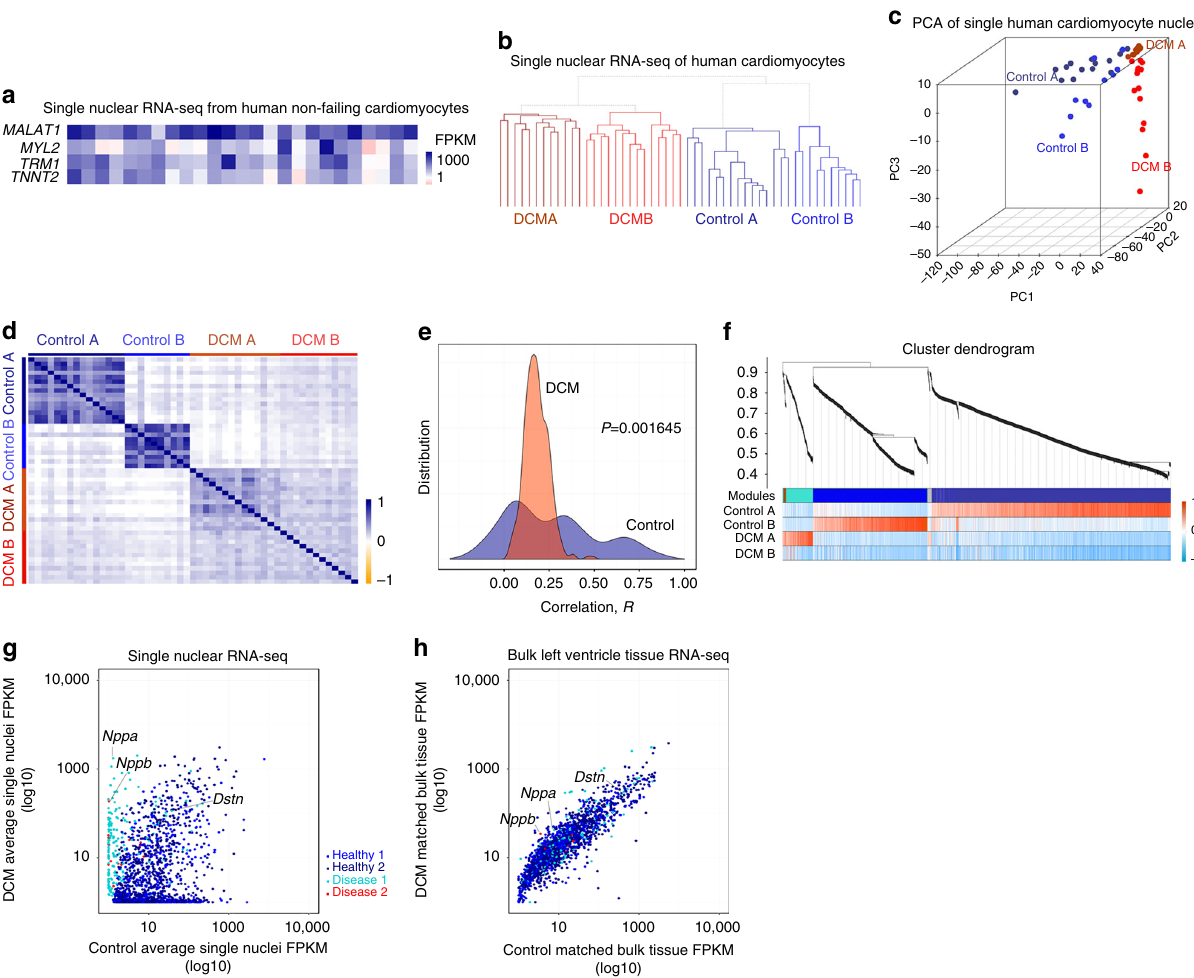
Fig. 3 Human single cardiomyocyte nuclear RNA-seq. a Core cardiac genes in human CMs are similar to mouse. b – d Unsupervised hierarchical clustering ( b ), PCA ( c ) and Spearman correlation analysis ( d ) produced 2 distinct subgroups in each of control and dilated cardiomyopathy ( DCM ) nuclei. e Density distribution of correlation shows narrower distribution for DCM nuclei compared to control. P value from Mann – Whitney U test. f WGCNA identi fi es gene modules (healthy 1, healthy 2, disease 1, and disease 2) that are speci fi c for DCM or control nuclear subgroups. g , h Classi fi ers from human gene modules show differential expression at single nuclear level ( g ), but not in matched bulk left ventricle RNA-seq ( h